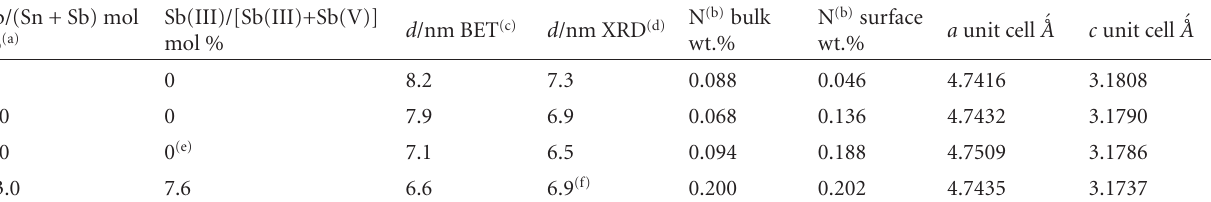
Table 1: Properties of the Sb:SnO 2 particles used [13].